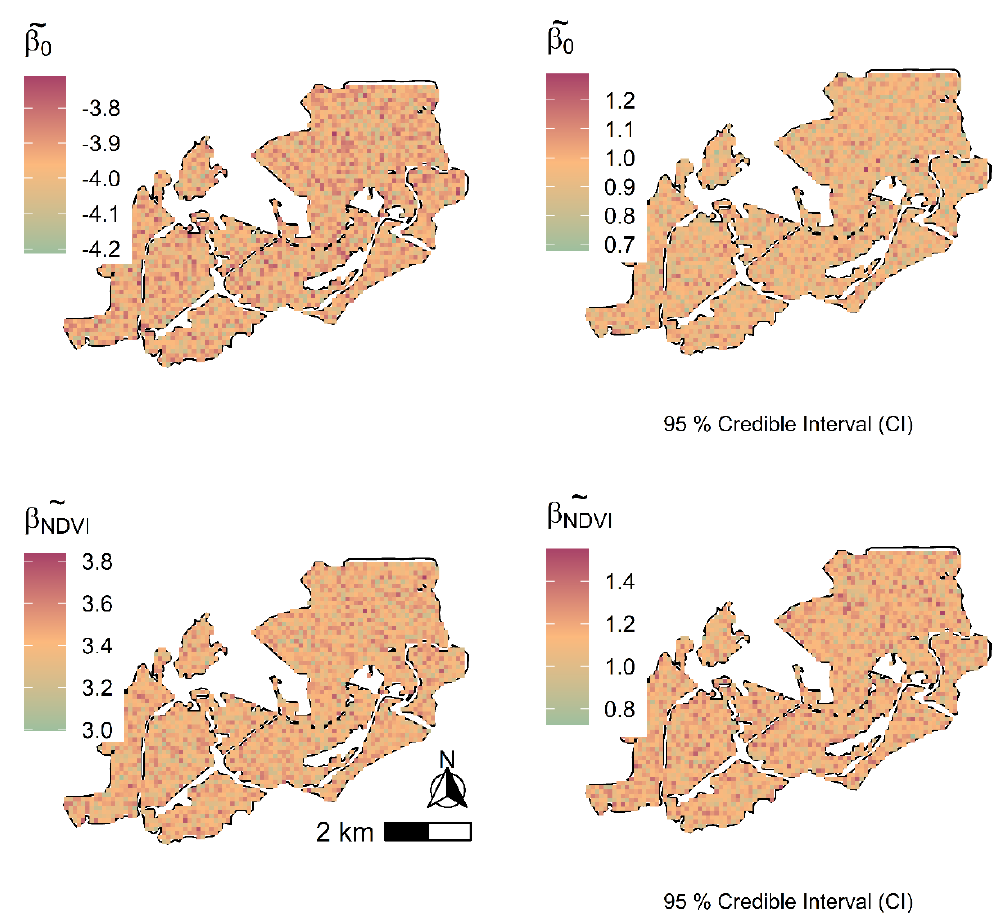
Figure 4. Sentinel-2-based C stock spatially varying coefficient maps alongside their 95% credible intervals for the SVC model.